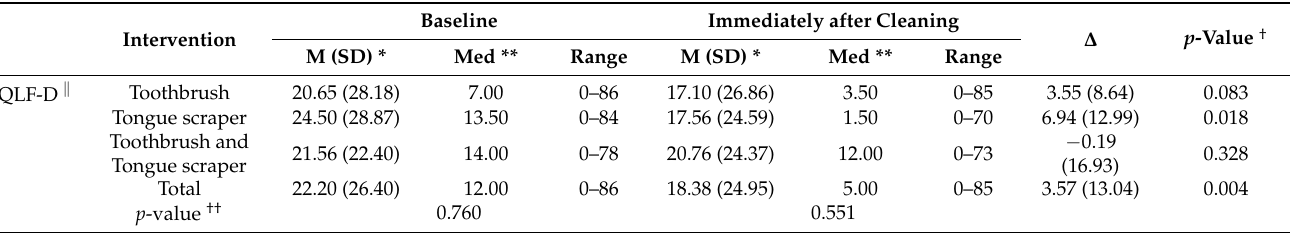
Table 5. Tongue coating score